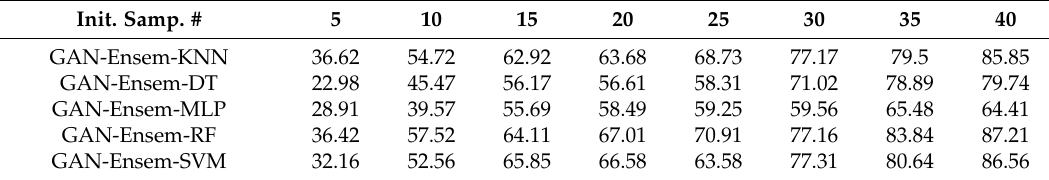
Table 4. The fault diagnosis accuracy rates (%) with different classifiers using GAN-ensemble to generate artificial training dataset.